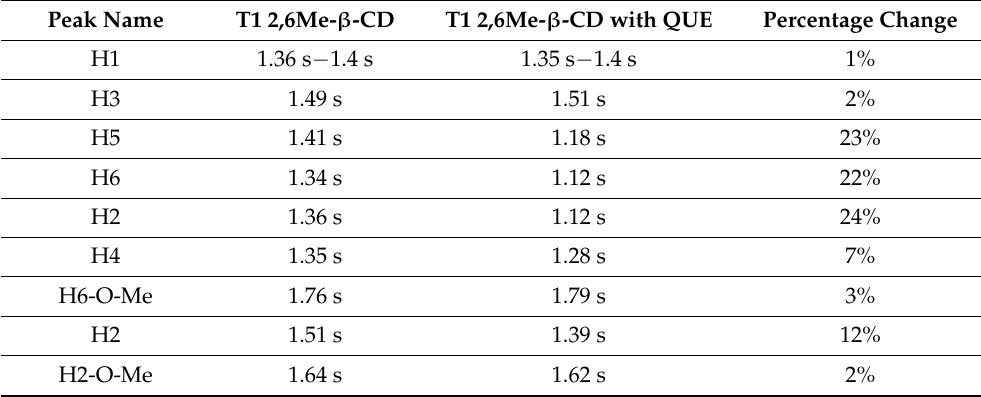
Table 7. T1 measurement for 2,6Me- β -CD before and after